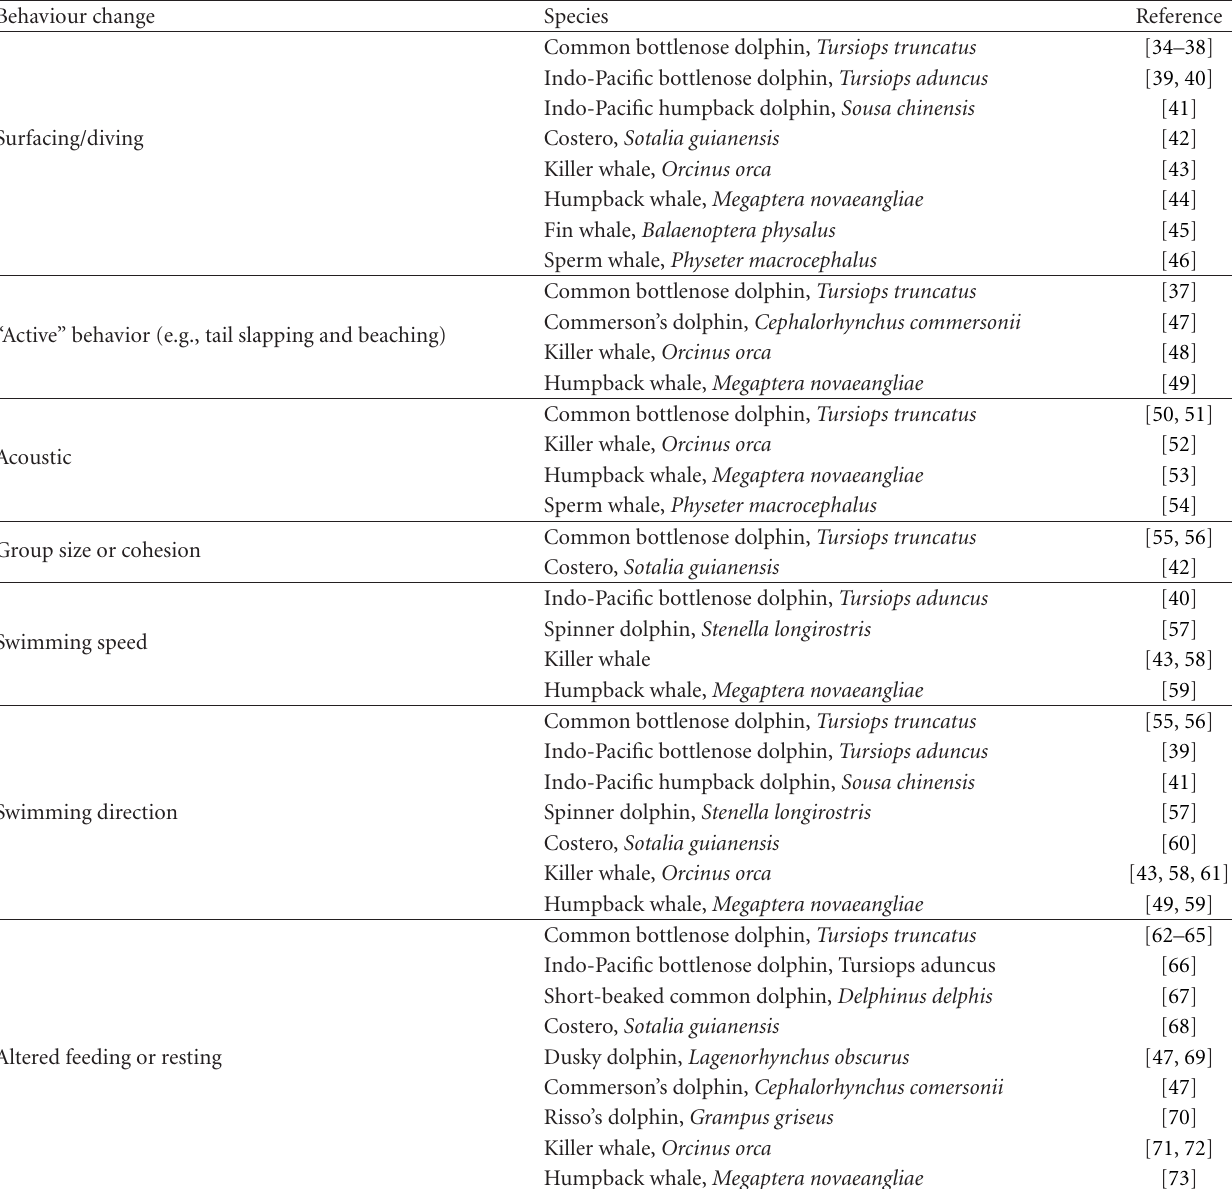
Table 1: Examples of behavioral changes observed in cetacean species in response to whale-watching tra ffi